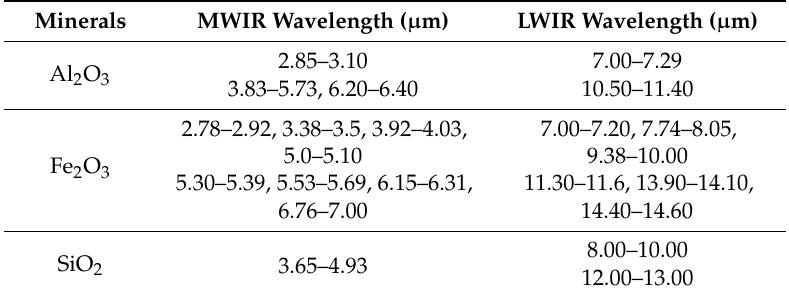
Table 4. The wavelength range of the features related to SiO 2 , Al 2 O 3 , and Fe 2 O 3 mineral composition extracted from the MWIR and LWIR reflectance datasets.